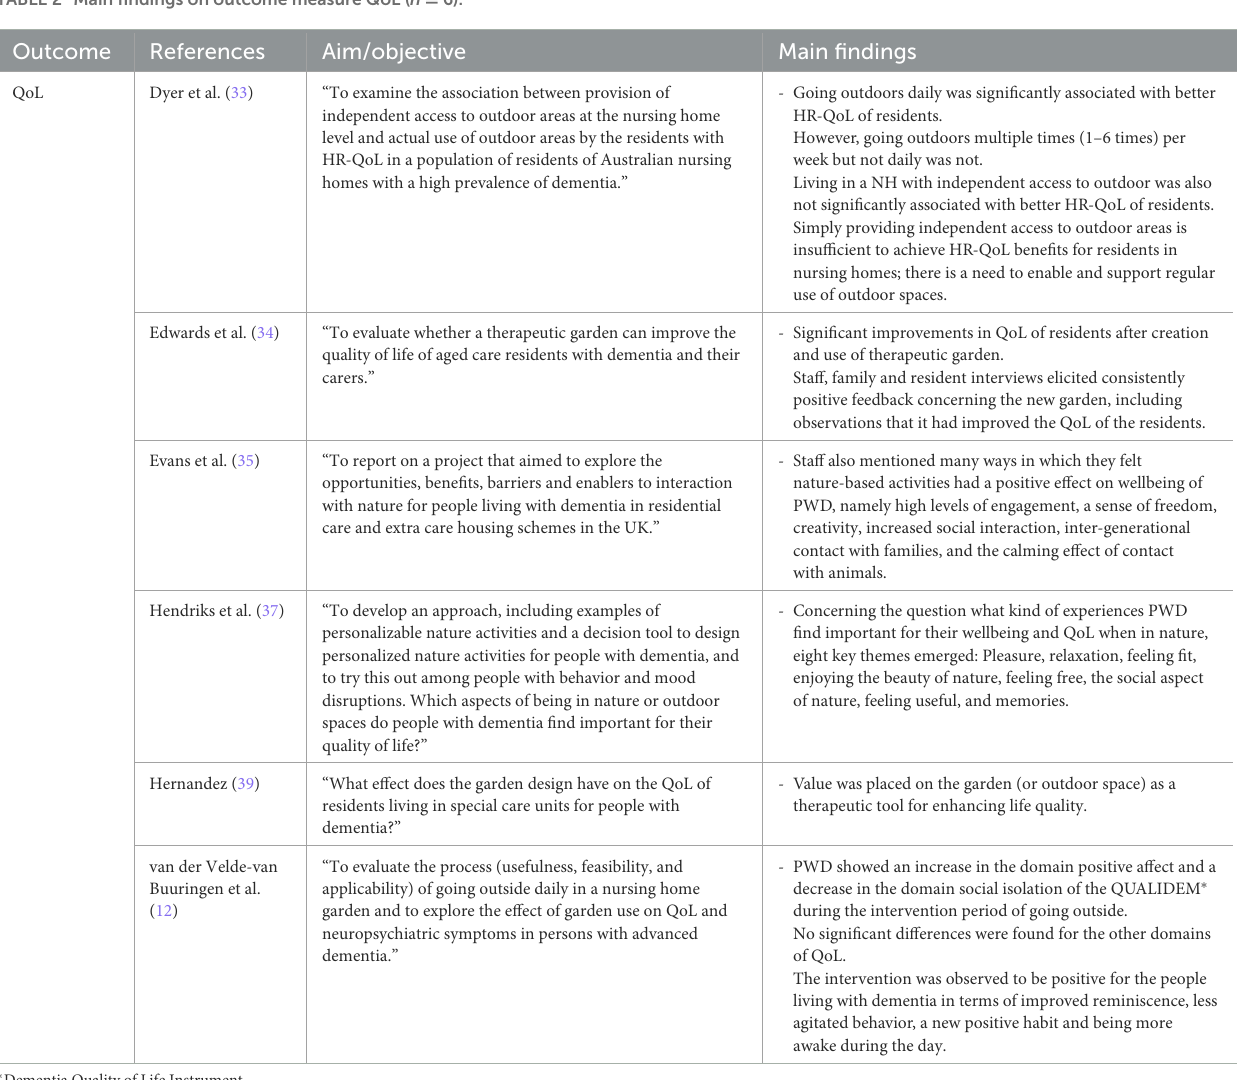
TABLE 2 Main findings on outcome measure QoL ( n =